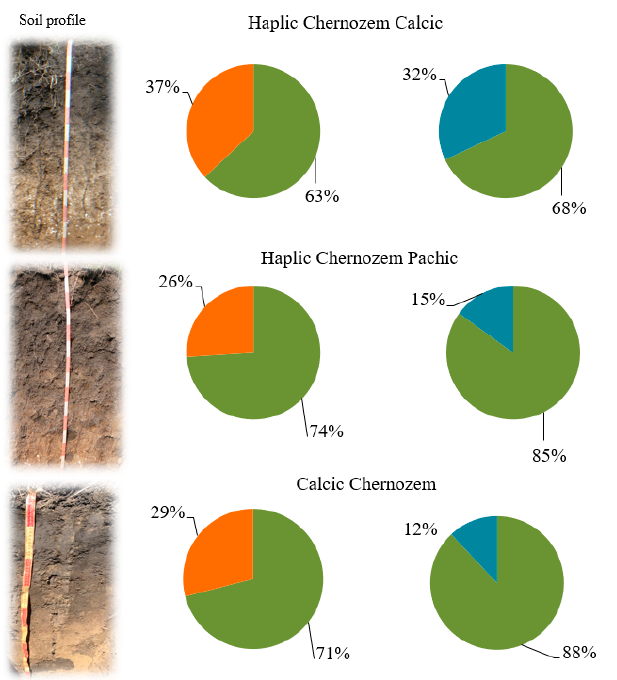
Figure 4. Comparative analysis of the stability of SOC content in NT and CT values expressed as % of